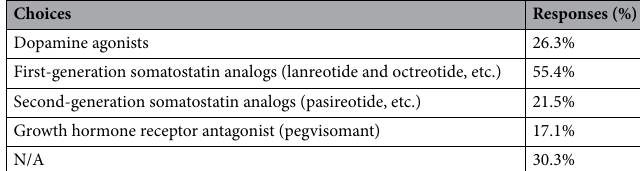
Choices Responses (%) Dopamine agonists 26.3% First-generation somatostatin analogs (lanreotide and octreotide, etc.)